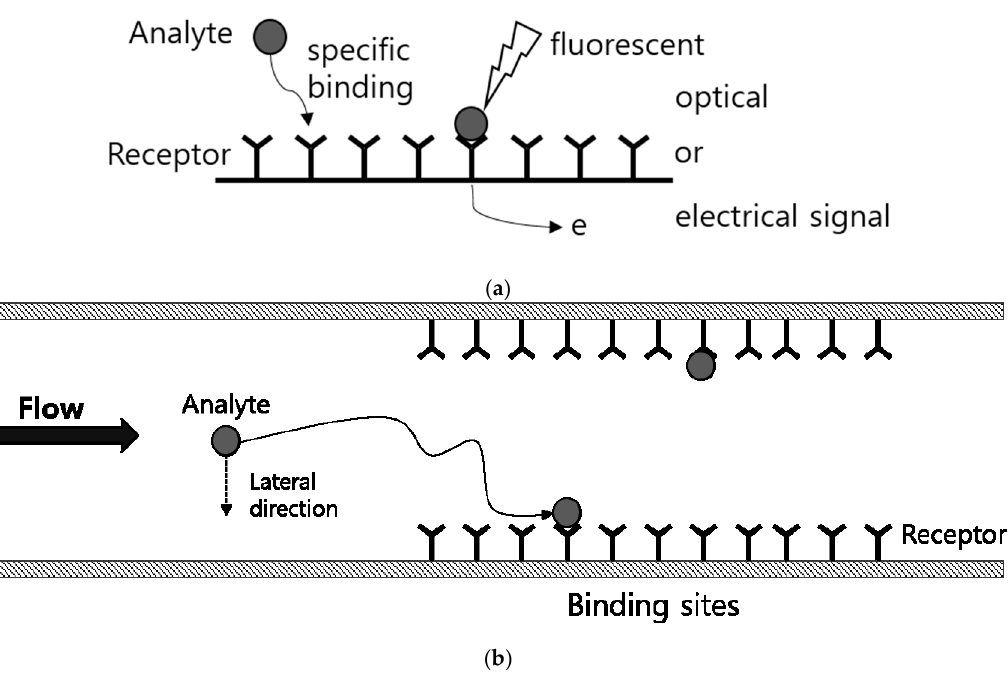
Figure 1. ( a ) Schematic of sensing mechanism for bio sensor. ( b ) Schematic of binding process between analyte and receptor in micro-channel.